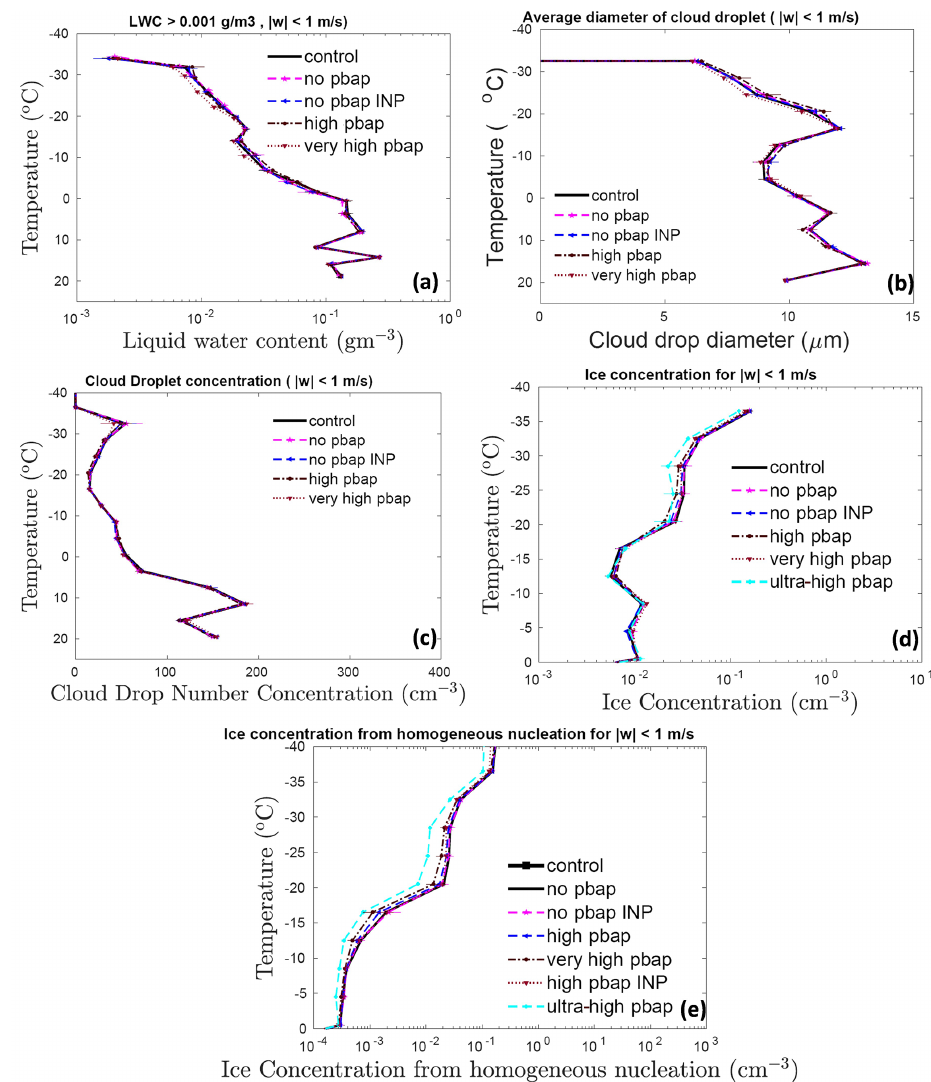
Figure 7. The temperature dependence of (a) the liquid water content, (b) the cloud droplet number, (c) the cloud droplet diameter, and the (d) total ice number concentration for the control simulation and various sensitivity runs involving a change in total PBAP number concentrations for in the stratiform region. Also shown is the temperature dependence of (e) ice concentration on homogeneous freezing. The averaging conditions are mentioned at the top of each figure. The total ice number concentration and ice number from homogeneous freezing from ultra-high PBAP are also shown in panels (d) and (e) . All the vertical profiles shown here are averaged for the whole domain. The error bars are based on ensemble